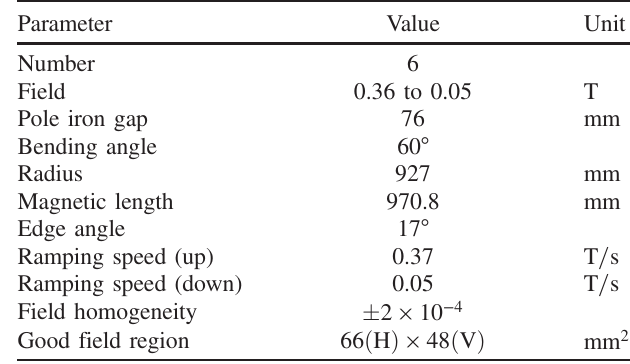
TABLE I. ELENA machine and beam parameters [5].